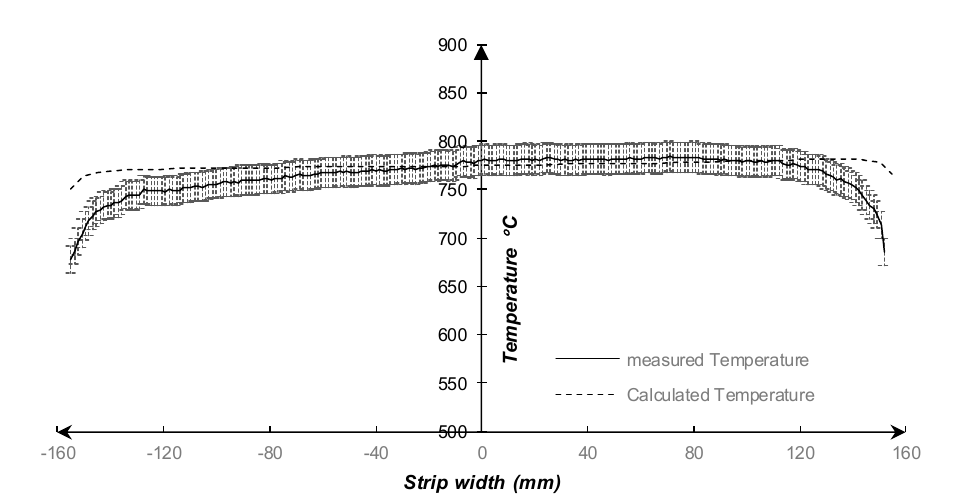
Figure 12. Comparison of the measured temperature with predicted value across the line I-I defined in Figure 11.